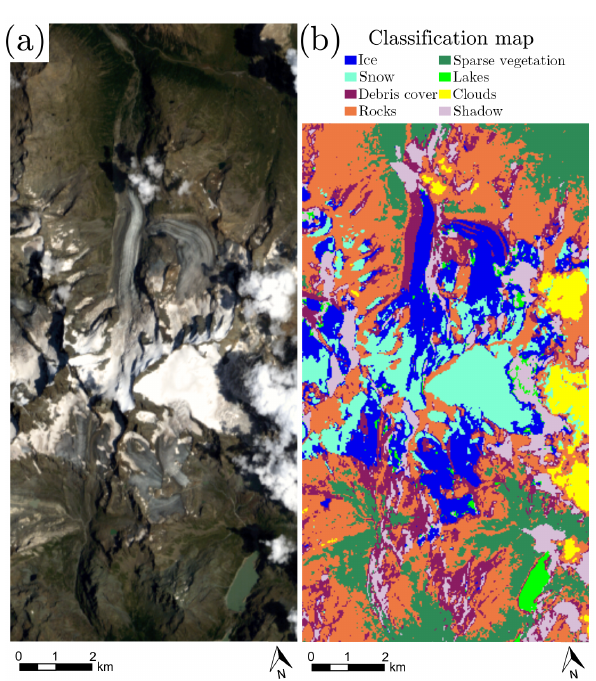
Figure 5. (a) True color representation of the Hyperion tile over the Bernina Range. (b) Classification map obtained using the support vector machine (SVM) algorithm.